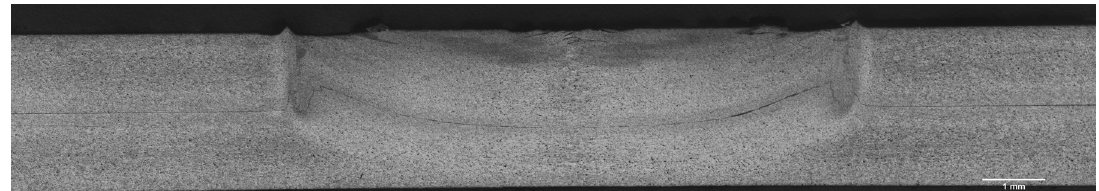
Figure 2. OM macrographs of a typical FSSW connection cross section showing the weld zones.